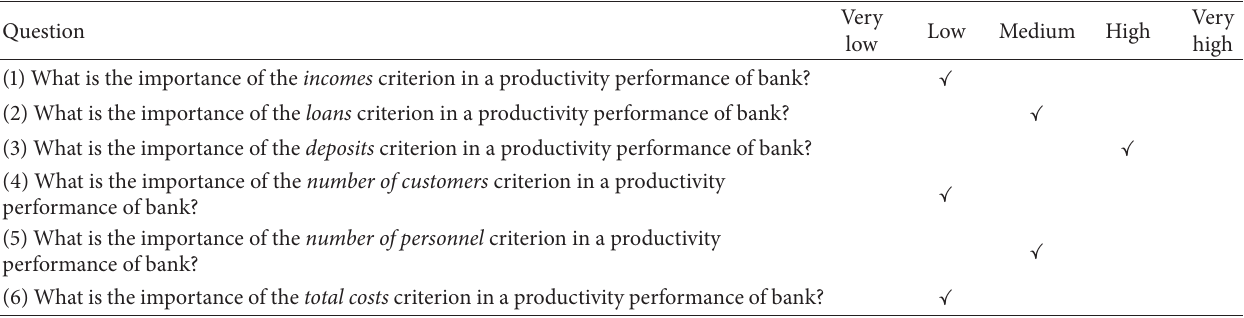
Table 5: A sample of filled up questionnaire.